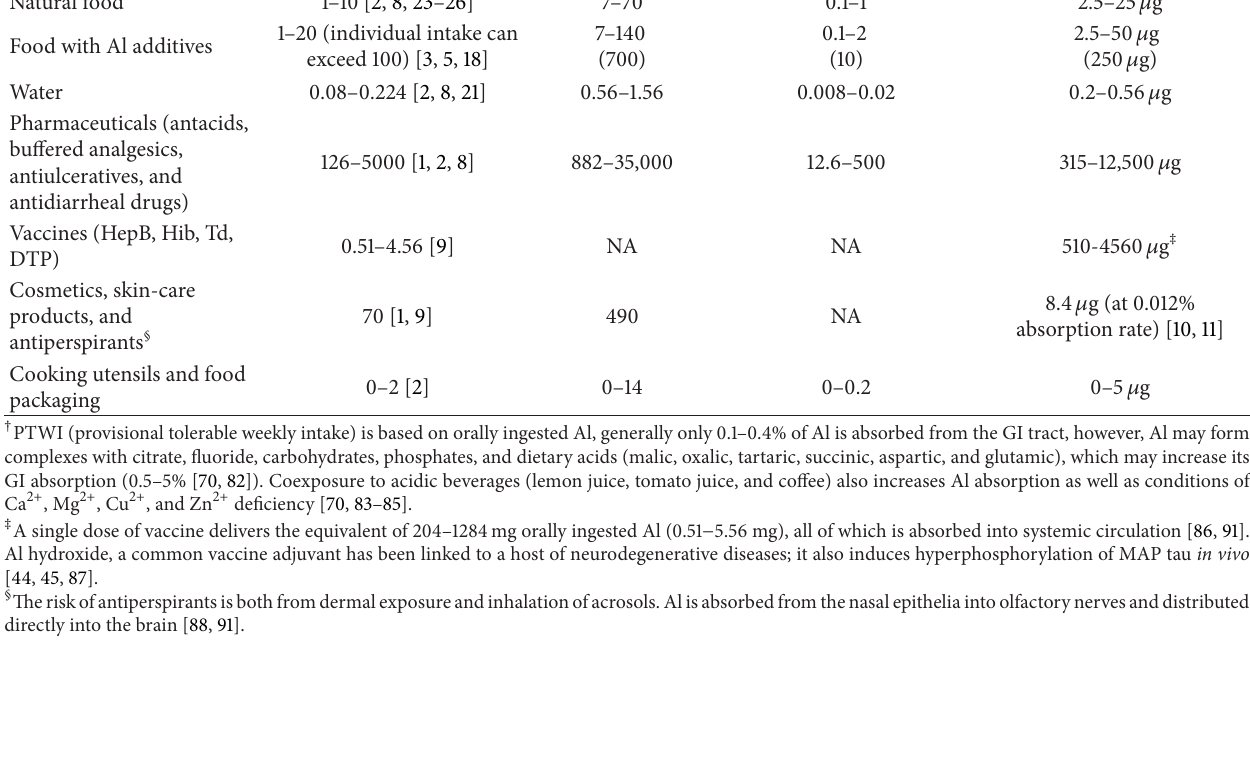
Table 3: A comparison of the physical properties of metallic Al with those of its common competitors in biological systems [89]. Crystal ionic radius source: [92]. Magnetic susceptibilities source: [47, pp. 4-131 to 4-136]. Viscosity 𝐵 coefficient source: [93]. Standard molar electrostriction volume source